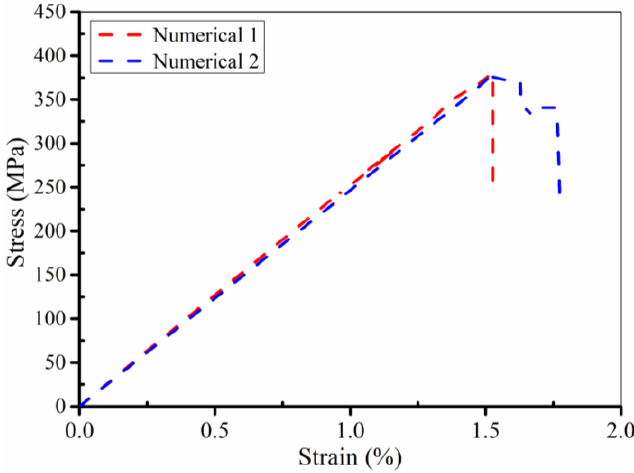
Figure 12. Comparison of GFRP laminates between original and new model.